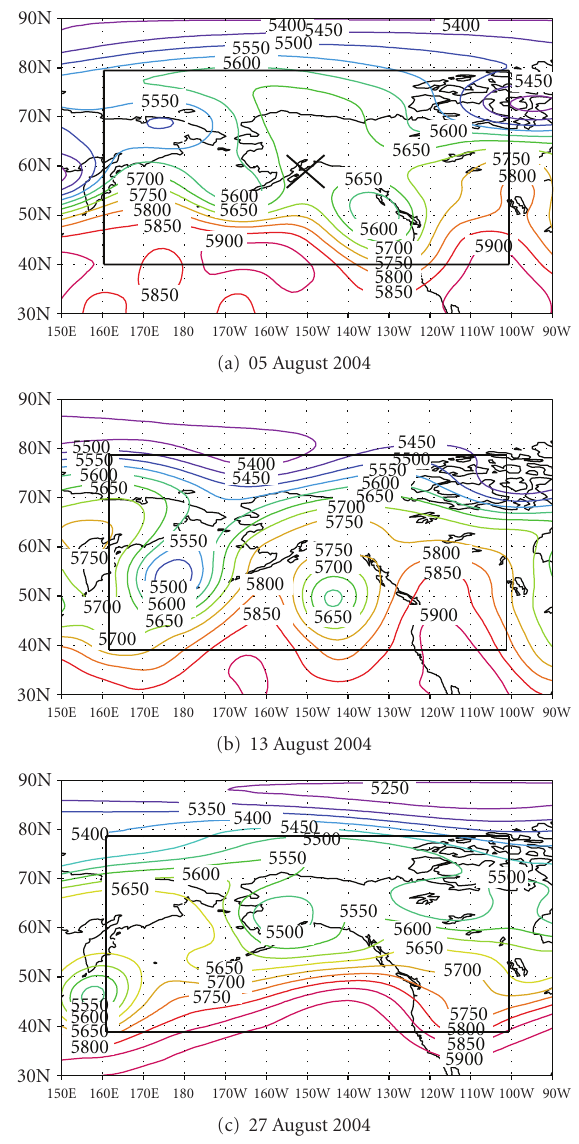
Figure 3: (a) The 500 hPa mean daily height. The cross indicates the center of blocking at the onset. The blocking domain boundary is marked around the center by thick solid black line. The continuous curves represent height contours at 50m interval, for 05 August 2004. Note the meridional (split)-flow character of the block; (b) for 13 August 2004; (c) for 27 August 2004.